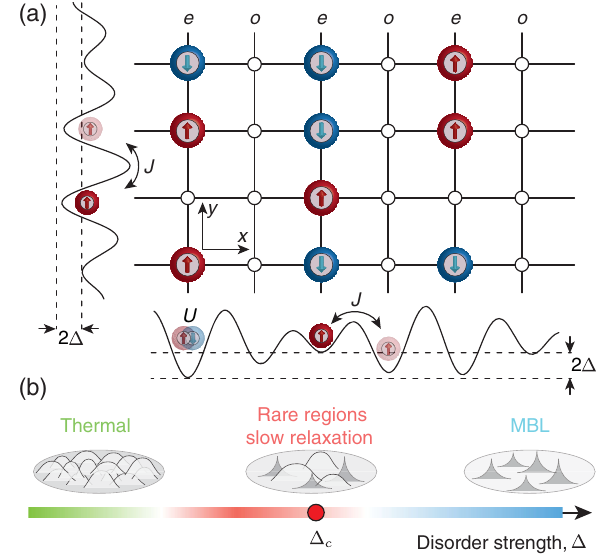
FIG. 1. Schematic of the experiment. (a) The system is initialized in a striped density-wave pattern of fermionic 40 K atoms in a random mixture of two spin states (red and blue) in a square lattice with tunneling matrix element J , quasiperiodic potential of strength Δ , and tunable on-site interactions U between the different spins. The largest realized 2D system is composed of approximately 200 × 100 sites with several thou- sand atoms. (b) For weak disorder strength, the system thermal- izes quickly (green area), whereas at strong disorder it is likely to exhibit a many-body localized regime (blue). Close to the transition (red dot, Δ c ), a regime of slow relaxation is observed (red area), potentially caused by locally insulating